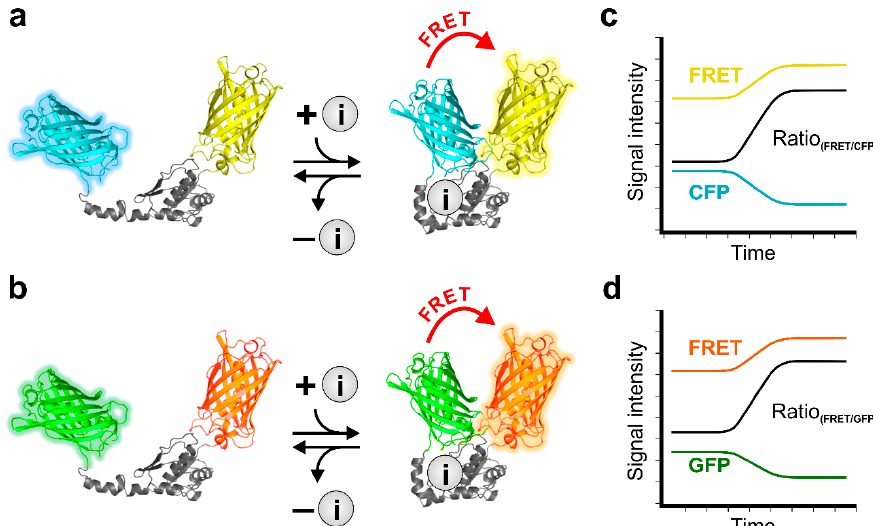
Figure 2. Schematic representation of the functional principle of genetically encoded probes (GEPs). Schematic representation of FRET-based indicators either containing ( a ) a CFP (cyan) and YFP (yellow) or ( b ) a GFP (green) and RFP (orange). In the ion (i, grey circles, a and b ) unbound conformation FRET efficiency is low, donor fluorescence is high. Upon ion binding to the ion sensitive domain, the probes undergo a conformational rearrangement, increasing FRET-fluorescence, while the donor fluorescence, i.e., CFP or GFP, is decreasing ( a and b , right panels). ( c , d ) schematically demonstrate the course of FRET- (yellow and orange curve, c and d ), donor fluorescence (CFP, cyan and GFP, green curve, c and d ), as well as the course of the resulting FRET-ratio signal of dividing FRET- by donor fluorescence (Ratio, black curves, c and d